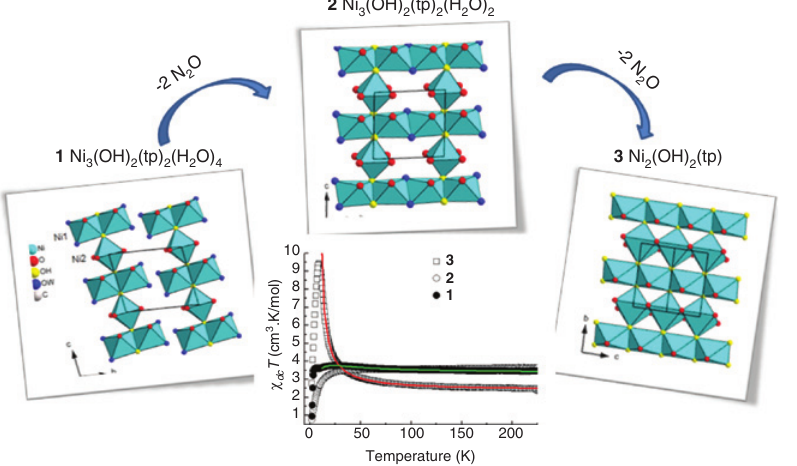
Figure 13: Processing inorganic metal-oxygen subunits of Ni hydroxy-teraphthalates from 1 to 3 by loss of coordination of water molecules and temperature dependence of χ T for the three compounds. The solid curves correspond to the parameterization of the experimental data using appropriate models. Reprinted with permission from [118]. Copyright 2014 American Society of